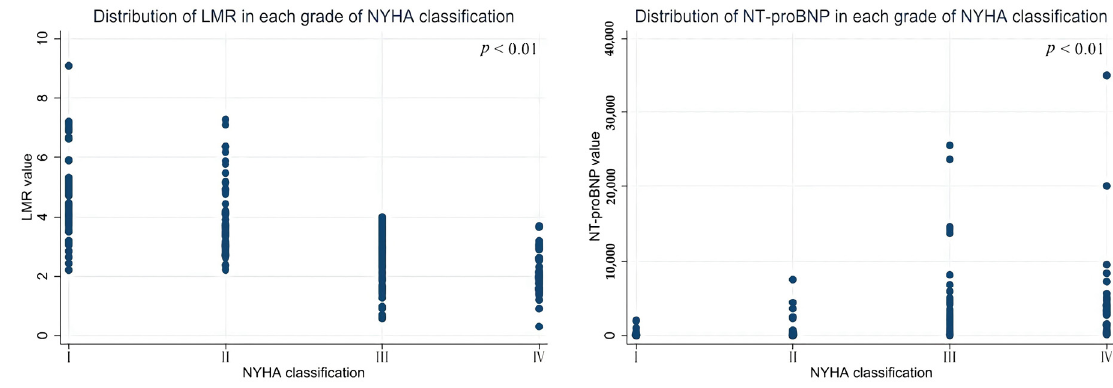
Figure 1. Distribution of LMR and NT-proBNP in different NYHA functional classifications. Table 5. Spearman correlation analysis of SII and NYHA functional classification.